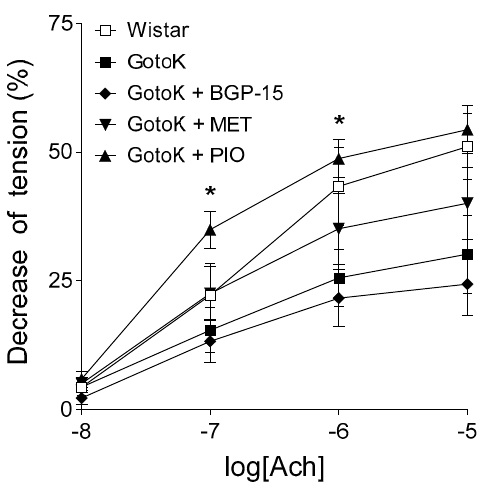
Figure 2. Relaxant effect of acetylcholine (Ach) on the abdominal aorta isolated from Wistar and Goto-Kakizaki rats, and GotoK rats treated orally with BGP-15, metformin or pioglitazone. All aortic rings underwent a pre-contraction elicited by norepinephrine before the administration of Ach. The axis x shows the common logarithm of molar concentration of Ach, while the axis y denotes the effect as a percentage decrease of the initial tension of aortic rings. The symbols represent the effect of Ach averaged within the groups ( ± SEM). Asterisks indicate the significance level of differences between responses to Ach in GotoK and pioglitazone-treated GotoK rats (* p < 0.05). n = 6/group, one-way ANOVA (with Geisser–Greenhouse correction) followed by Tukey post-testing.